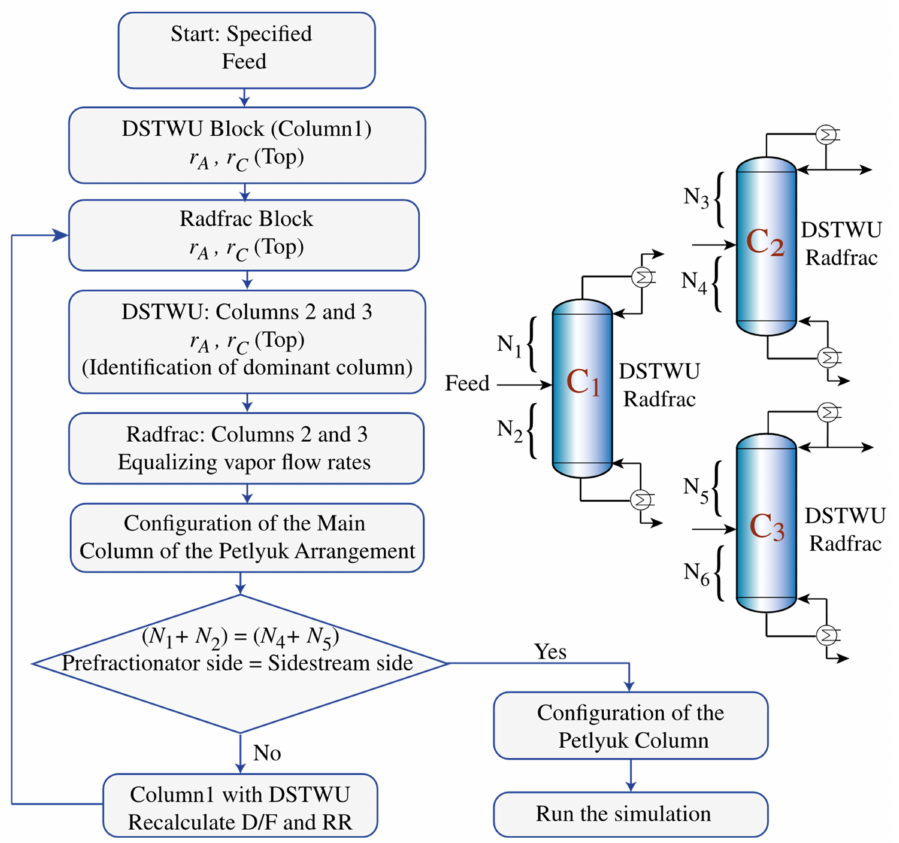
Figure 3. Adapted methodology of the Triantafyllou and Smith